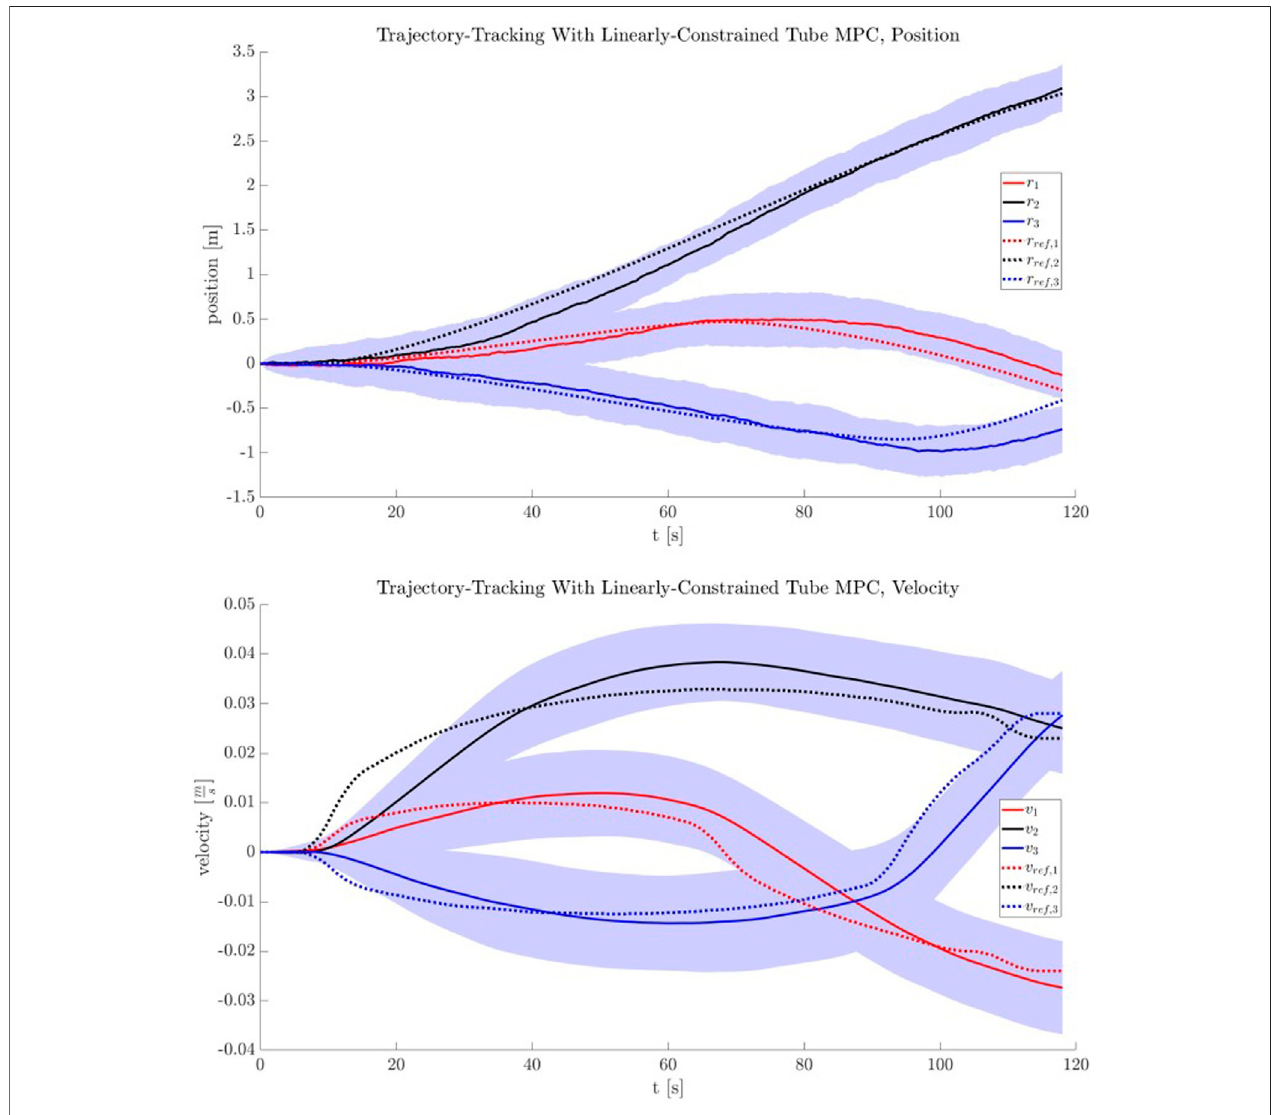
FIGURE 9 | The position and velocity tracking performance for the robust tube MPC, with shading indicating 1- σ bounds of n (cid:2) 100 Monte Carlo trials. Note that nominal MPC and ancillary controller tuning can have a signi fi cant impact on controller performance (as with any MPC).